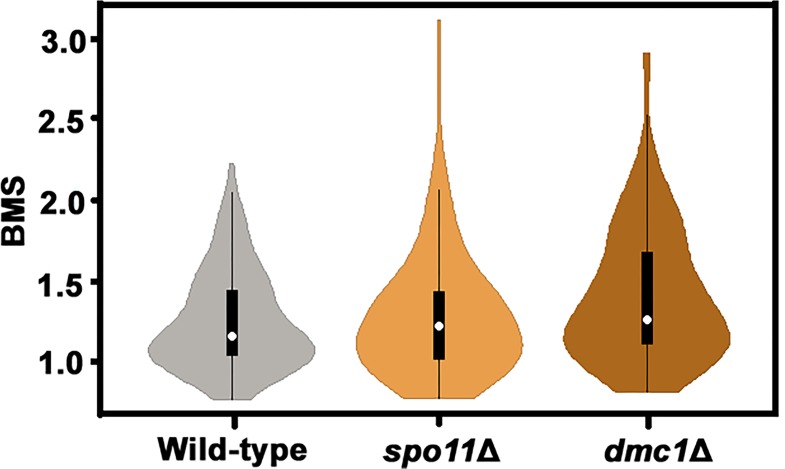
Violin plots showing the distribution frequency of the BMS in different strains.α cells from XL280 and its derived mutants were incubated on V8 agar in the dark at 25°C to induce the unisexual mating response for 7 days. n = 118 for each strain.10.7554/eLife.38683.005Figure 1—figure supplement 1—source data 1.Source file for Figure 1—figure supplement 1.